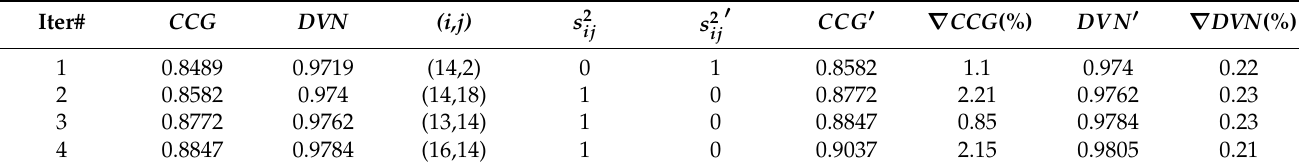
Table 16. Modification process of the individual skeleton matrix S 2 .